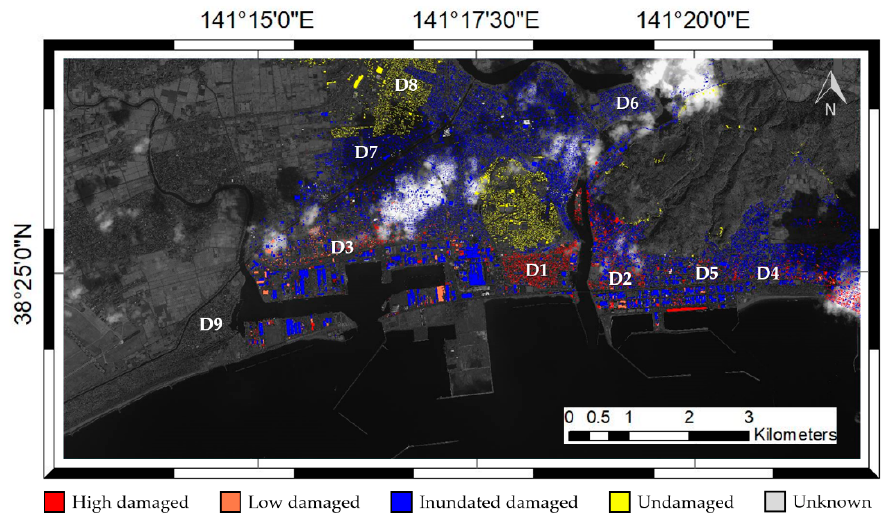
Figure 6. Map of building damage [53]. The building damage is categorized into five classes: High, low, and inundated-damaged, undamaged, and unknown. The locations of the nine selected districts for the validation, described in Section 5.2, are labeled as D1 to D9. The base image is the panchromatic image of the KOMPSAT-2 data.